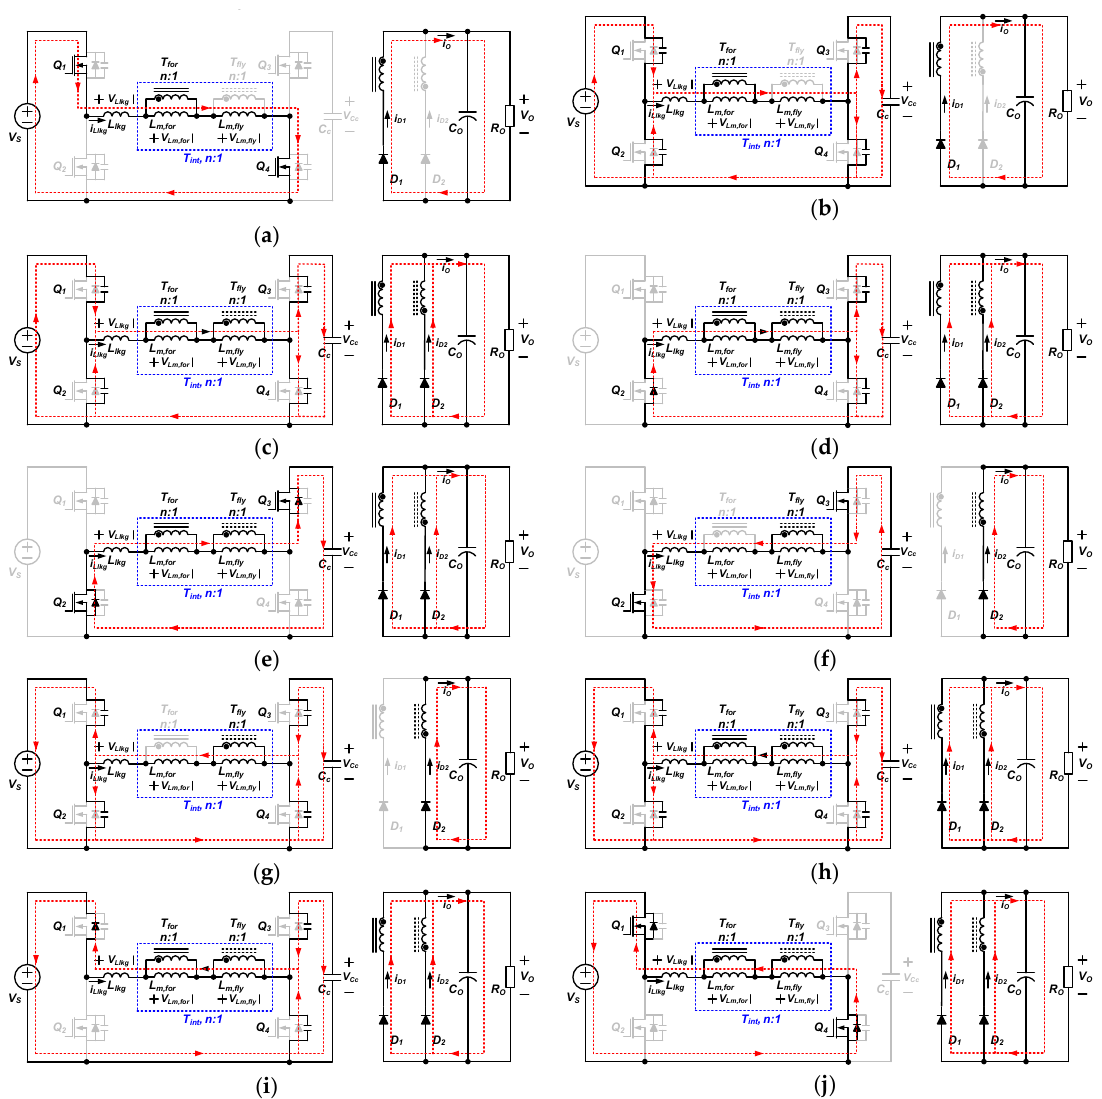
Figure 6. Topological state of proposed converter. ( a ) Mode1( t 0 – t 1 ). ( b ) Mode2( t 1 – t 2 ). ( c ) Mode3( t 2 – t 3 ). ( d ) Mode4( t 3 – t 4 ). ( e ) Mode5( t 4 – t 5 ). (f) Mode6( t 5 – t 6 ). ( g ) Mode7( t 6 – t 7 ). ( h ) Mode8( t 7 – t 8 ). ( i ) Mode9( t 8 – t 9 ). ( j ) Mode10( t 9 – t 0 ’).